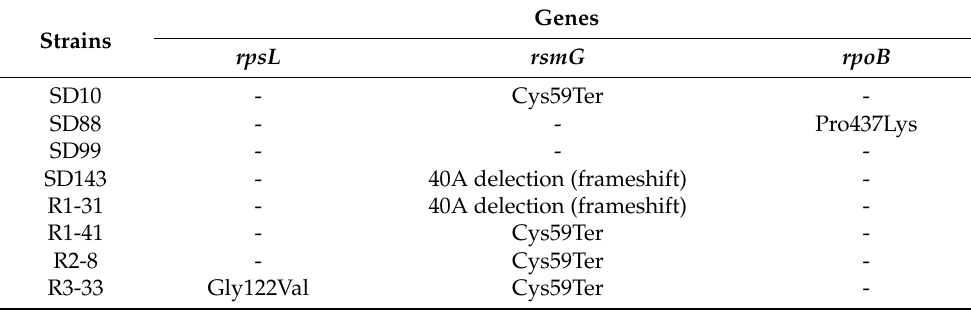
Table 3. The relative genotype of stains after genome